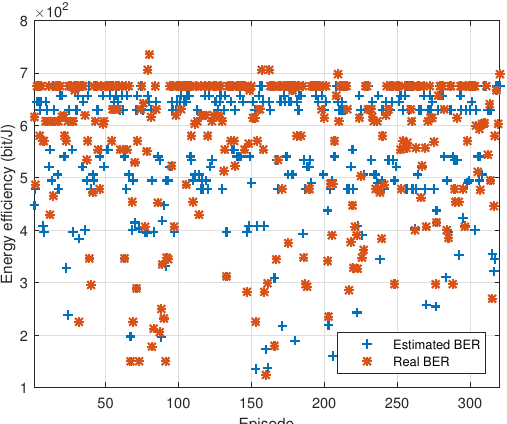
Figure 9. The performance of the proposed DDQN scheme based on the real BER and estimated BER.